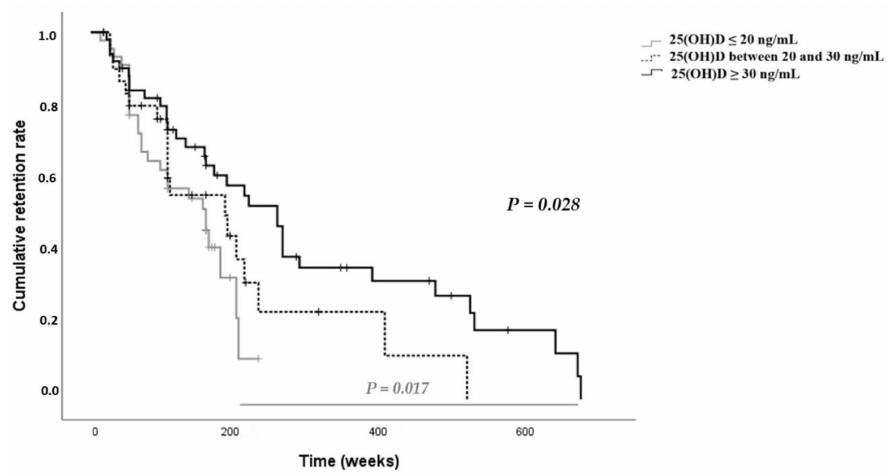
Figure 2. Kaplan–Maier method. First biological drug survival in the groups of PsA patients with different statuses of vitamin D serum level: 25(OH)D ≤ 20 ng/mL, 25(OH)D between 20 and 30 ng/mL, and 25(OH)D ≥ 30